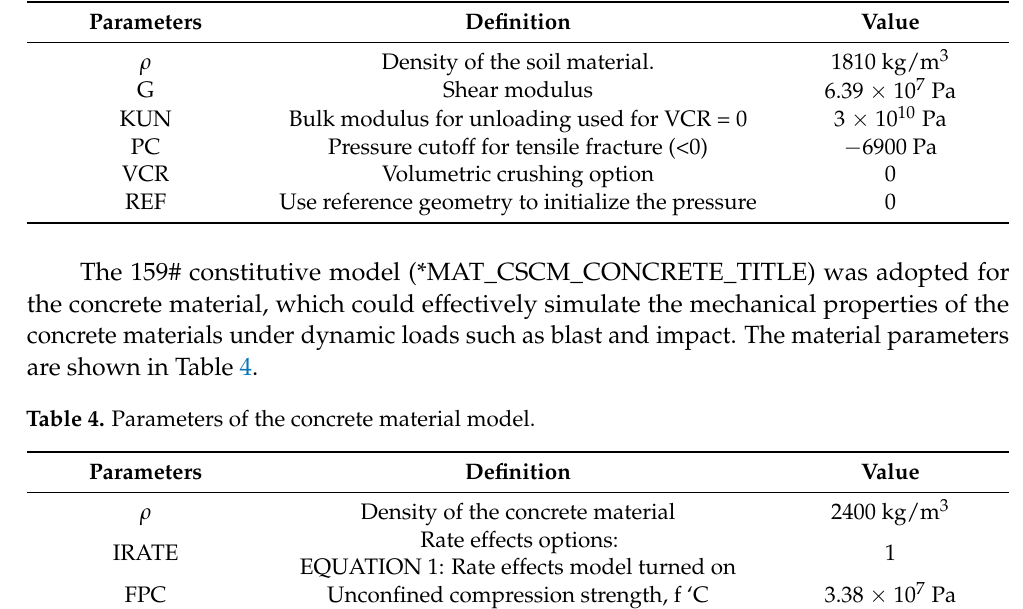
Table 3. Parameters of the soil material model.